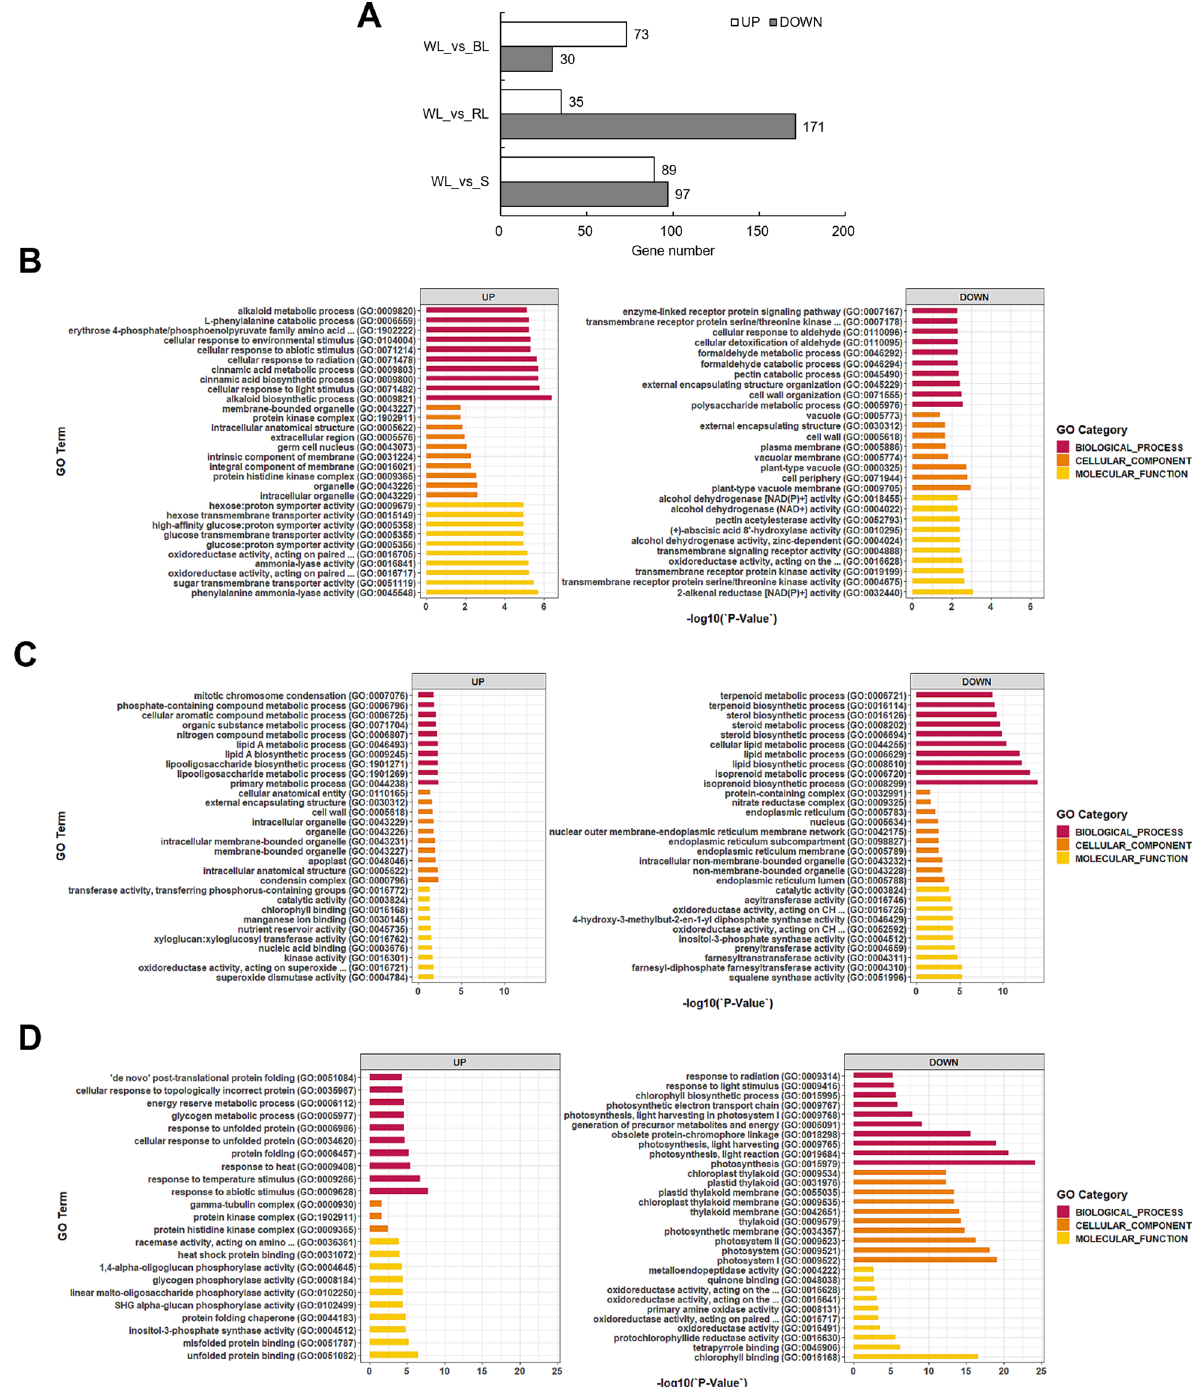
Fig. 1 Differentially expressed genes (DEGs) for GO Annotation categories. A Number of DEGs under light quality treatment (Log2(FoldChange) and padj < 0.05). The GO analysis of genes in B WL vs. BL C WL vs. RL and D WL vs. Shade treatments. X‑axis indicates the richness factor in log 10 p‑value. Y‑axis represents various GO terms (refer to the color